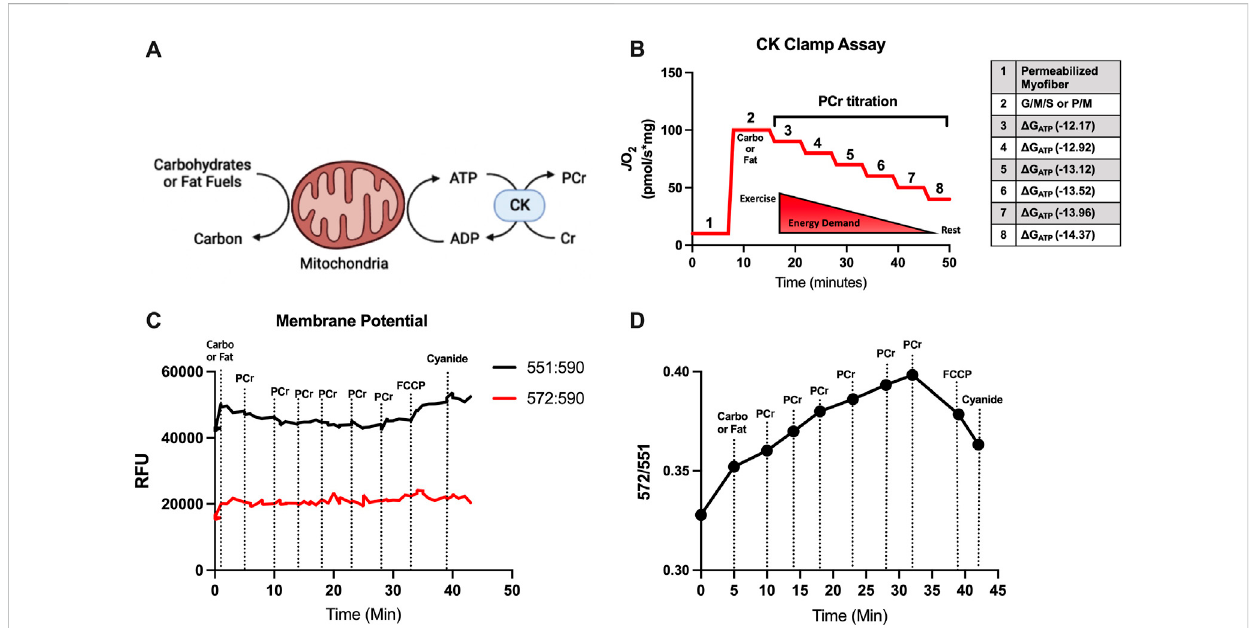
FIGURE 1 Conceptual framework for CK Clamp technique and mitochondrial membrane potential evaluation. (A) Creatine kinase (CK) is catalyzes the reversible reaction of creatine (Cr) and ATP to produce phosphocreatine (PCr) and ADP. (B) During the CK Clamp test, the ATP re-synthesis demand ( Δ G ATP )canbemanipulatedbytitratingPCrandhastheeffectofdecreasingoxygenconsumption(JO 2 ). (C,D) Arepresentativemitochondrialmembrane test detecting the change in TMRM throughout the CK Clamp. The ratio of the 572-to-551 excitation/emission fl uorescence is used to indirectly assess the polarization of the mitochondrial membrane. The reversing of mitochondrial membrane polarization was con fi rmed by sequential addition of an uncoupler (FCCP) and